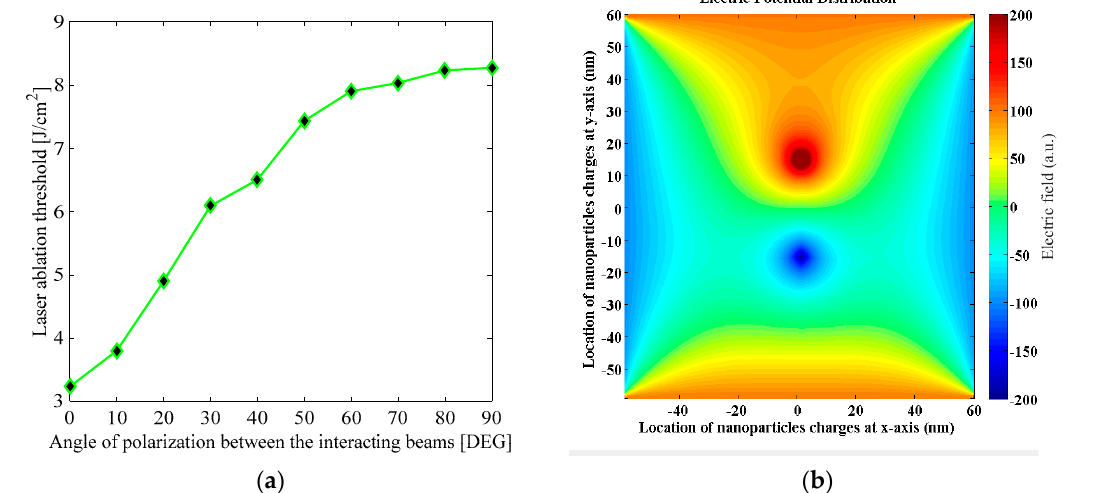
Figure 11. ( a ) Laser ablation threshold as a function on the angle between the planes of polarization of the incident beams in the cells with incorporated Au NPs; ( b ) Electric potential distribution field in a pair of Au